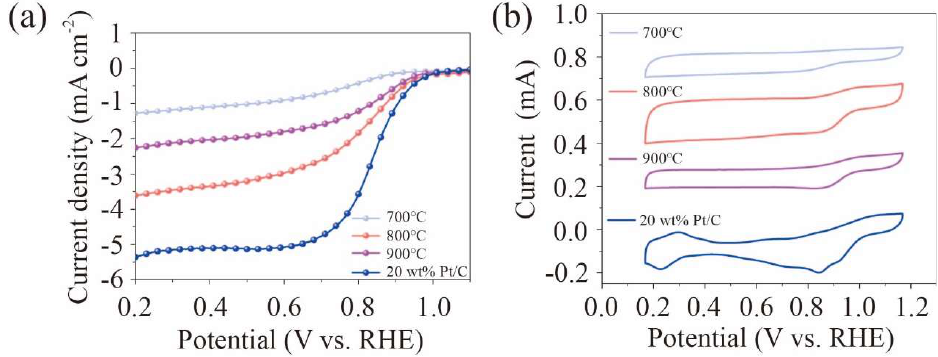
Figure 4. ( a ) RDE LSVs and ( b ) CVs of 20 wt.% Pt/C and MNNC-2 with different carbonization temperatures at a heating rate of 2 °Cmin −1 measured in O 2 -saturated 0.1 M KOH and at a scan rate of 10 mV s −1 . The rotation speed for LSV test was 1600 rpm.